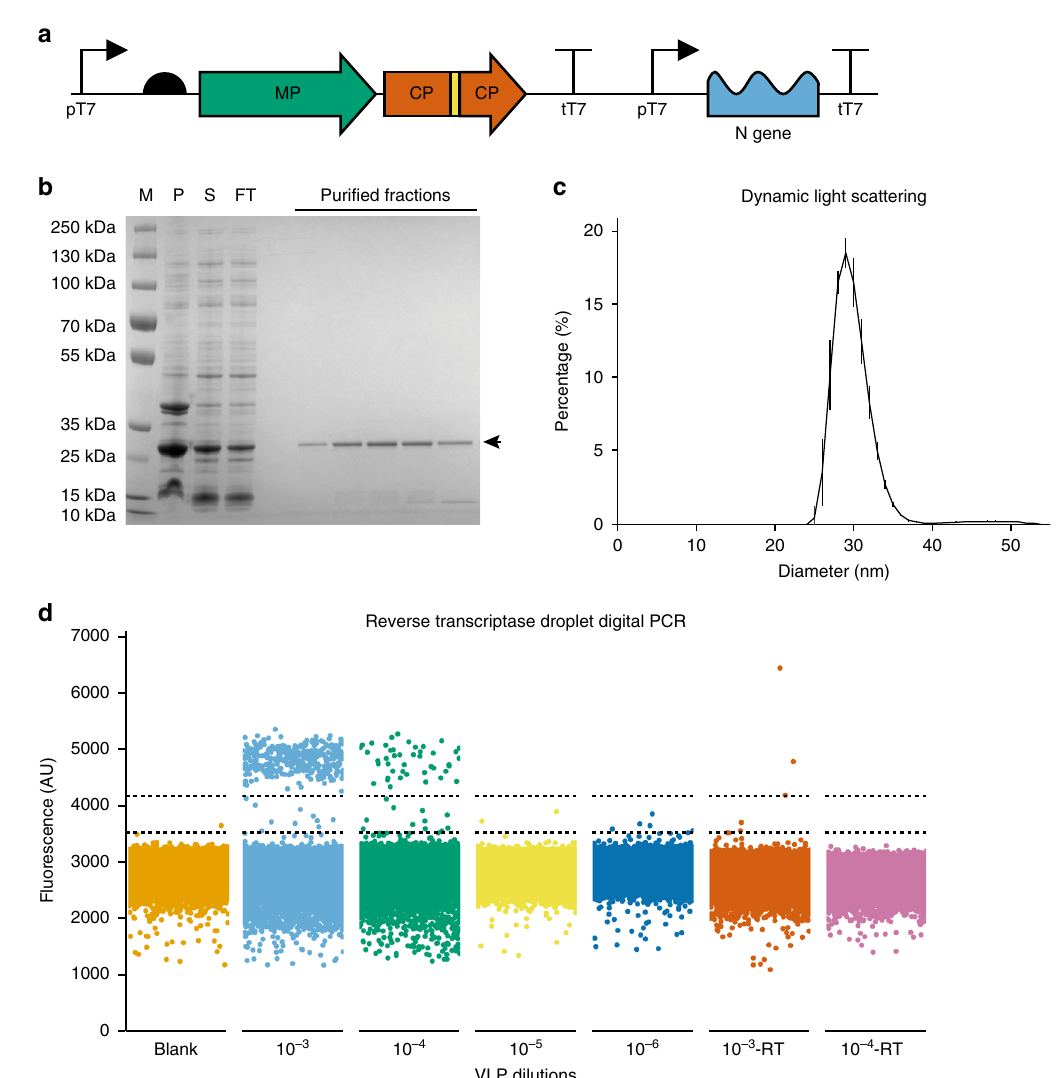
Fig. 1 MS2-SARS-CoV-2 VLP production and characterization. a Schematic of the genetic construct of the engineered MS2-SARS-CoV-2 N-gene VLP encompassing the MS2 maturation protein (MP) in green and coat proteins (CP) in orange, linked via His-tag (yellow), under transcriptional control of the T7 promoter and T7 terminator sequences. The SARS-CoV-2 N protein RNA is packaged using a downstream pac site . Schematic created using DNAplotlib 31 . b The VLP constructs were expressed in E. coli and puri fi ed using HiTrap ® TALON ® Crude and HiTrap ® Heparin columns. SDS-PAGE analysis of the puri fi cation steps includes a protein marker (M) followed by pellet (P) and soluble fraction (S) of the cell lysate, followed by the column fl ow through (FT) and protein elution fractions, where the CP-His-CP dimer (~28 kDa) is indicated by an arrow. c Puri fi ed VLPs were analysed by dynamic light scattering (DLS), which showed a uniform particle population of ~27 nm. Error bars represent the SD of three technical replicates. d Reverse-transcriptase droplet digital PCR (RT-ddPCR) was performed for absolute quanti fi cation of the puri fi ed VLPs. Serial dilutions of 1, 10, and 100 thousand-fold of the puri fi ed VLPs in the presence and absence of a reverse transcription (RT) enzyme were analysed. Droplets were clustered using a threshold determined using a python implementation of an online tool (http://de fi netherain.org.uk). Dotted lines represent the cut offs for the positive and negative clusters. Any data points between the two dotted lines are considered droplet “ rain ” . Source data are available in the Source Data fi